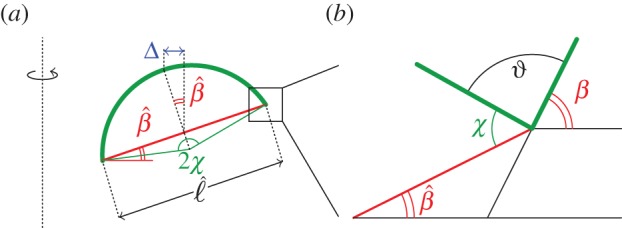
Geometric details in the derivation of the effective energy. (a) Hoop strains generated by rotation and inward bending. (b) Geometry of formation of second bend region: close-up of the region where the active bend region matches up to the undeformed shell.